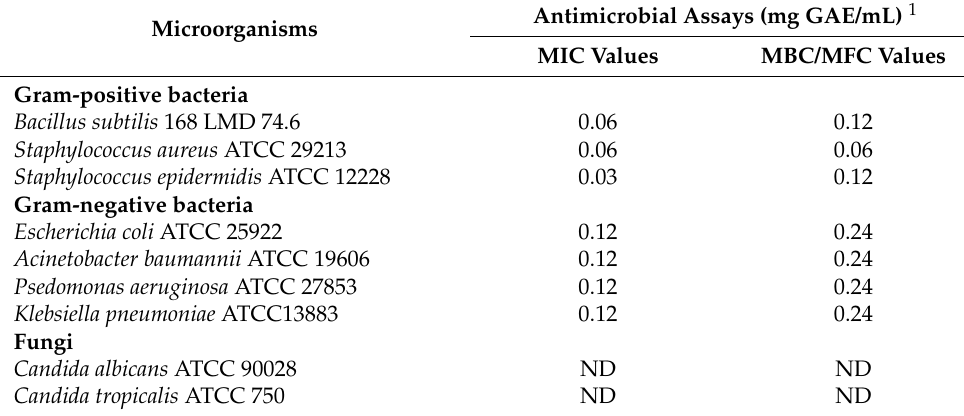
Table 4. Antimicrobial activity of umbu fruit peel extract. Antimicrobial Assays (mg GAE/mL) 1 Microorganisms MIC Values MBC/MFC Values Gram-positive bacteria Bacillus subtilis 168 LMD 74.6 0.06